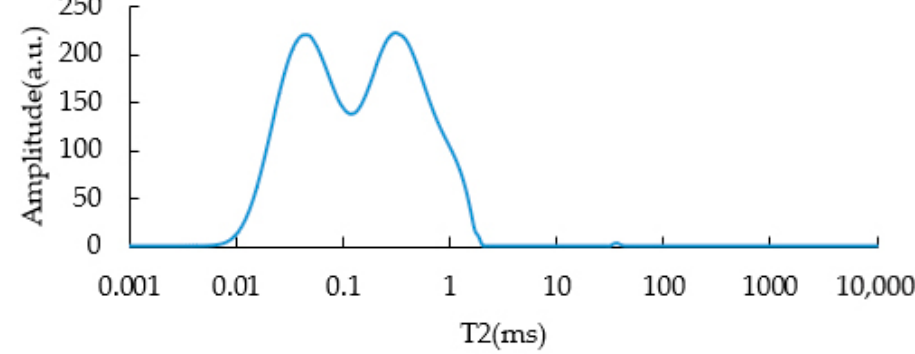
Figure 1. T2 of base asphalt binder unaged.